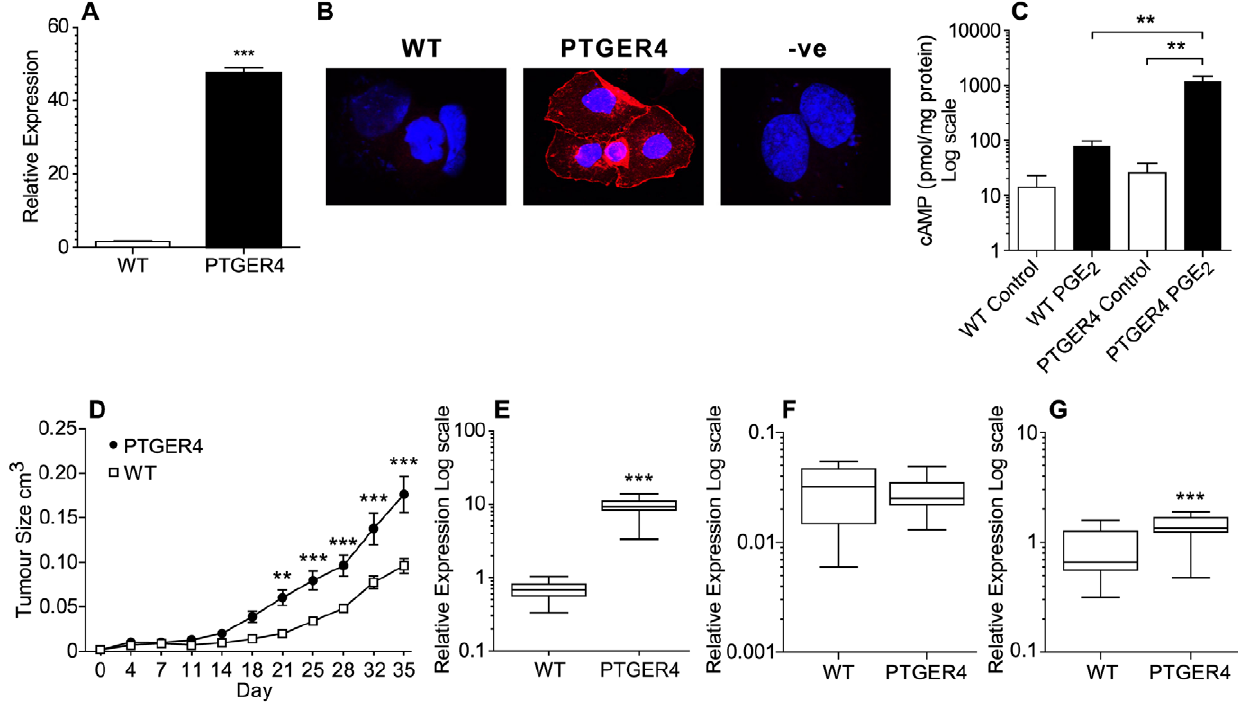
Figure 2. PTGER4 enhances tumour growth in a nude mouse xenograft model. ( A ) PTGER4 mRNA expression in WT Ishikawa cells compared with Ishikawa cells stably transfected with the full length PTGER4 cDNA transcript (n=3). ( B ) Immunolocalisation of PTGER4 expression in WT and PTGER4 stable cell lines. ( C ) cAMP accummulation in WT and PTGER4 stable cell lines in response to treatment with 100 nM PGE 2 for 0 or 5 minutes (n=3). ( D ) Tumour growth in CD1- Foxn1 nu mice following dorsal flank injection with either Ishikawa WT or PTGER4 stable cells. Tumour growth in WT (n=20) and PTGER4 (n=20) xenografts was monitored over a 35 day period as described in the methods. ( E ) PTGER4 ( F ) PTGS1 and ( G ) PTGS2 mRNA expression in either Ishikawa WT (n=10) or PTGER4 (n=10) xenograft tumours. **, *** represent significance at P , 0.01 and P , 0.001.